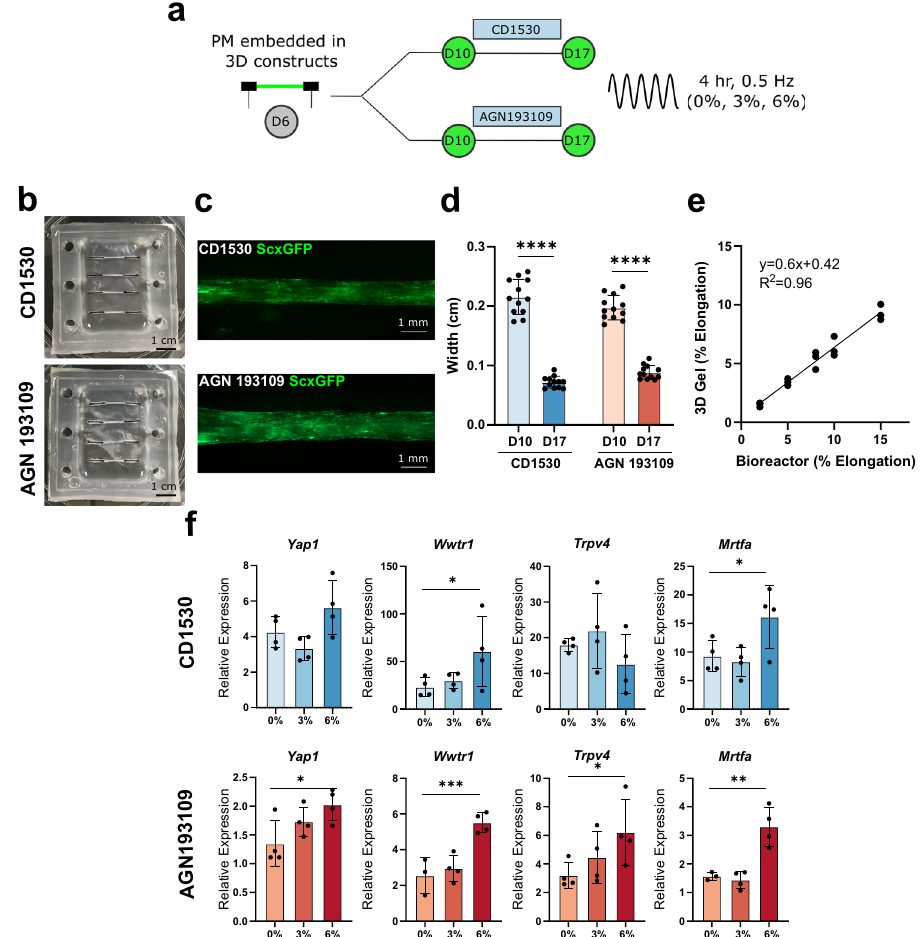
Fig. 7 Dynamic tensile loading of 3D engineered tendon and fi brocartilage tissues activates mechanotransduction markers. a Schematic of experimental design. Gels were dynamically loaded at D17. b Successful generation of contracted 3D cell-seeded gels in custom PDMS dishes at D17. c Whole-mount ScxGFP fl uorescence imaging of 3D gels at D17. d Quanti fi cation of gel contraction ( n = 12 independent gels, one-way ANOVA with Tukey ’ s posthoc tests). Data represented as mean ± SD. e Validation of % elongation experienced by 3D gels with bioreactor loading ( n = 3 independent gels, Pearson ’ s correlation). f Real-time qPCR analysis of known mechanotransduction markers with 4 h of dynamic loading ( n = 4 independent gels, one- way ANOVA with Fisher ’ s LSD tests). Data represented as mean ± SD. * p < 0.05, ** p < 0.01, *** p < 0.001, **** p < 0.0001. Source data are provided as a source data fi